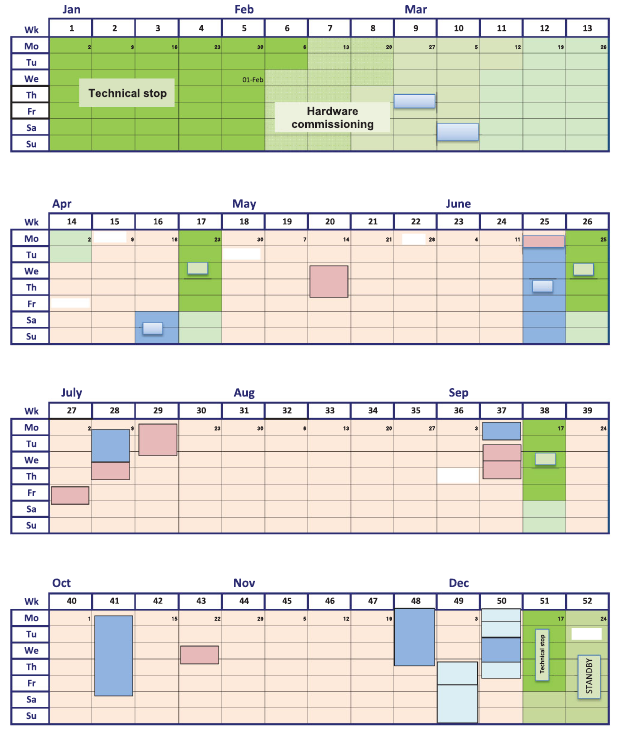
FIG. 4. LHC schedule for 2012 [65]; time scheduled for physics is marked with light